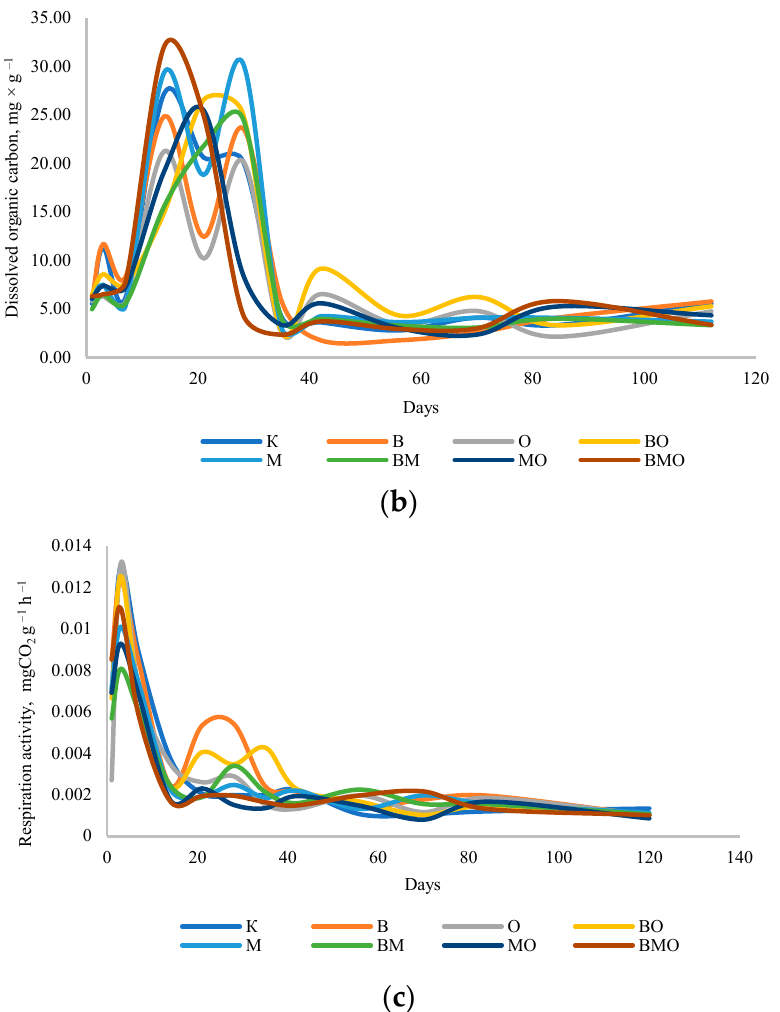
Figure 1. Temperature ( a ), dissolved organic carbon content ( b ), and respiration activity ( c ) of the compost mixtures.